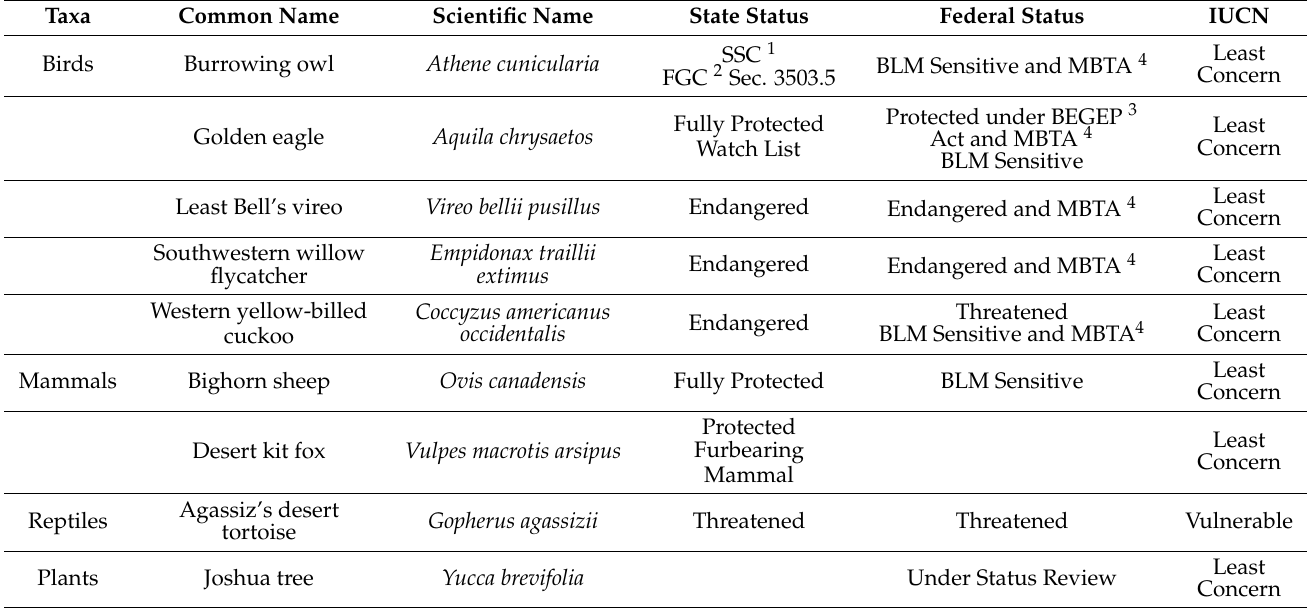
Table 2. Proposed covered species for the Apple Valley Multi-Species Habitat Conservation